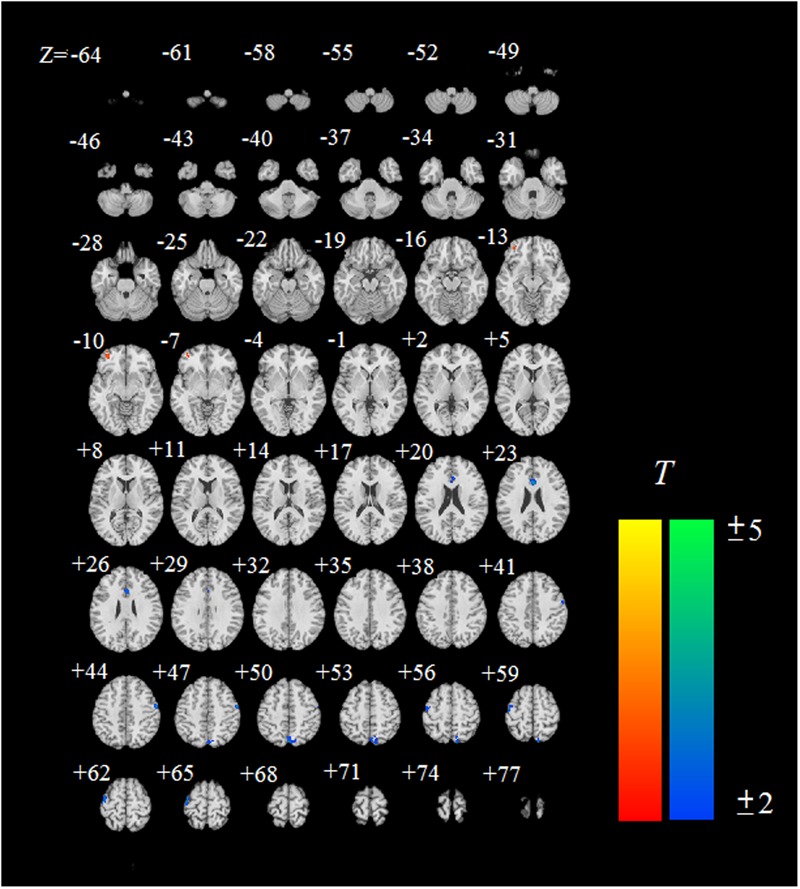
Brain regions showing significant difference in IGD subjects compared with RGU subjects. The IGD subjects showed enhanced activation (shown in red) in the left orbitofrontal cortex (OFC), and decreased activation (shown in blue) in the right anterior cingulate cortex (ACC), right precuneus, left precentral gyrus and right postcentral gyrus when comparing to the RGU group. ‘Z = ’ is the z coordinate of the slice in MNI space.